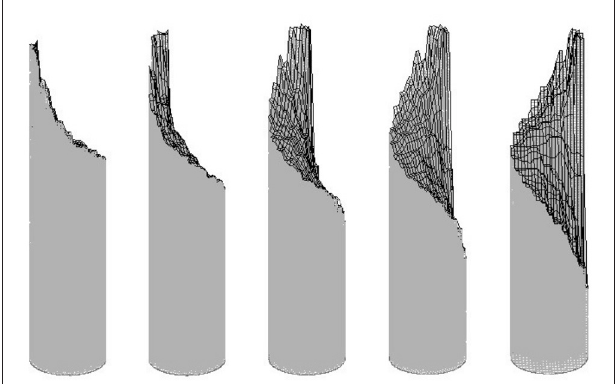
FIGURE 17 | A cylindrical shaft with diameter d = 25 and height H = 201 which has been broken on the application of torque. The fracture criterion used is Equation (22). The shaft is shown from five slightly different